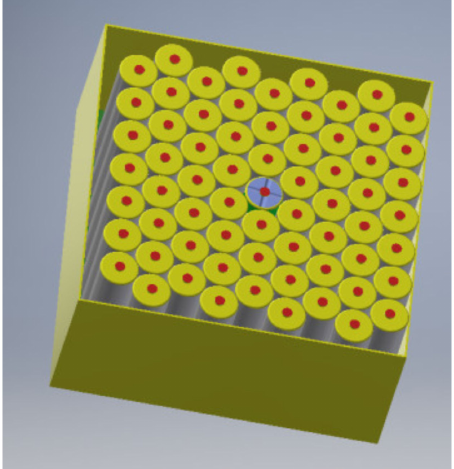
Figure 3. Illustrative arrangement of cells in an enclosure with limited cooling. In such cases, an online temperature (and voltage) control of each cell is essential, with the optional use of a gas sensor (so-called smart nose [23]) if